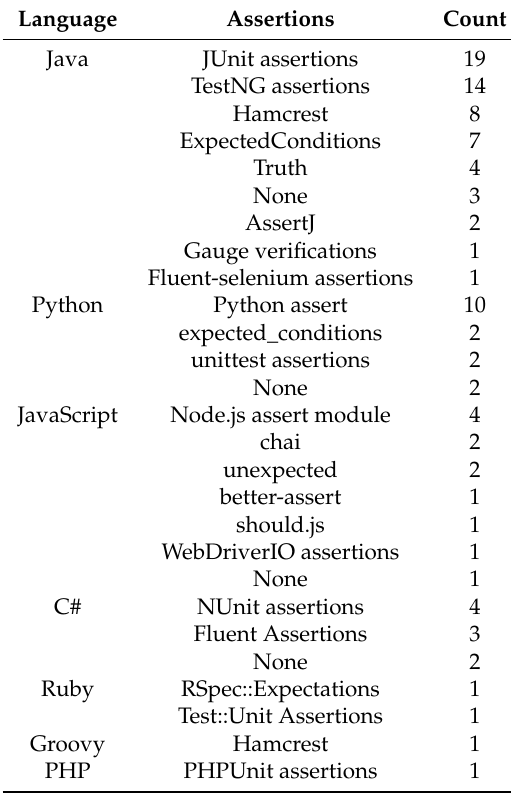
Table A6. 2.d. What kind of assertions do you implement in your Selenium